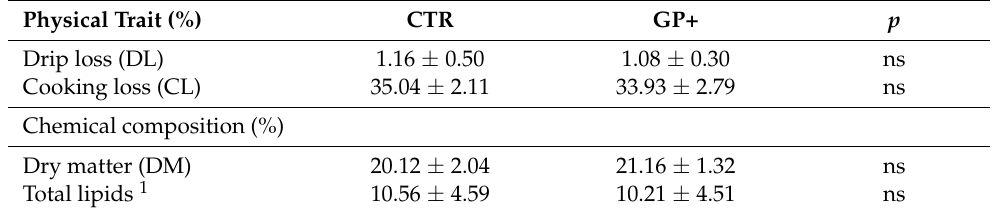
Table 2. Physical and chemical characterization of the raw longissimus dorsi muscle from lambs fed with a standard diet (CTR) and lambs fed with a diet containing grape pomace (GP+). Physical Trait